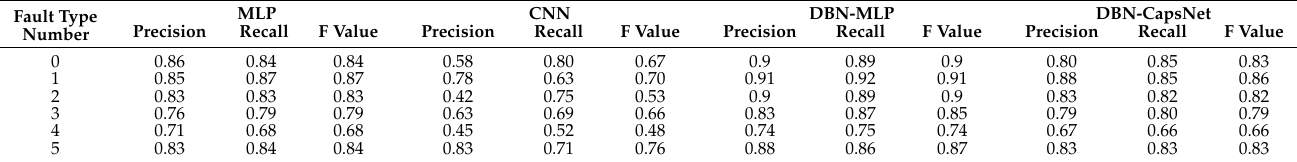
Figure 7. Comparison of loss rate convergence. Table 2. The precision rate, recall rate, and F value of MLP, CNN, and